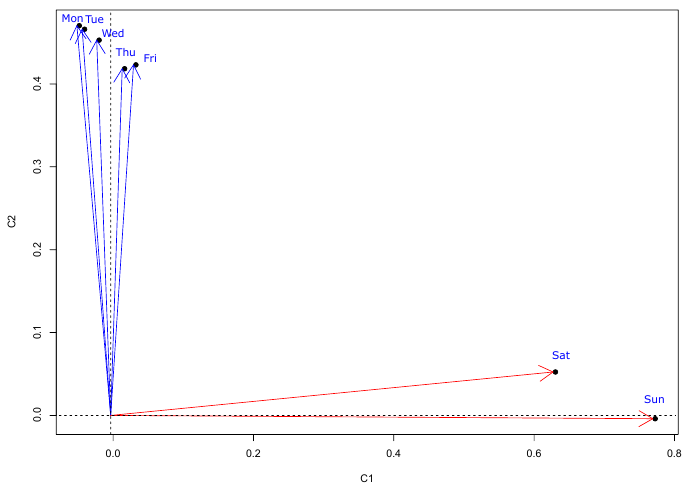
Figure 10. Component scores for matrix C . Weekdays are shown in blue and weekend days in red. The station scores (shown for prototypical stations in Table 6) indicate the position of each station on these dimensions. When discarding small station scores, most stations have high loadings on one dimension and a few on both dimensions. It is important to note that the stations that score high in one component score negatively in the other one. For example, Roquetes and Santa Rosa are the stations with the highest loading on the first dimension, Fira and Mas Blau the stations with the highest loading on the second dimension, and Poblenou and Hospital de Sant Pau load high on both dimensions. Therefore, three clusters of stations can be considered. The stations belonging to each cluster are shown in Table